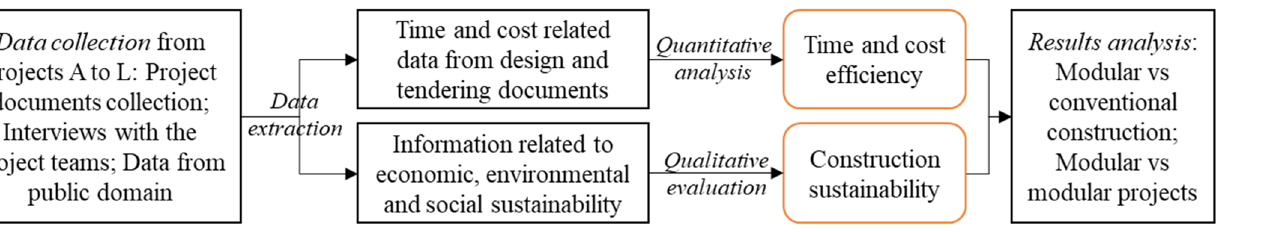
Figure 4. Research process of the cross-case study.